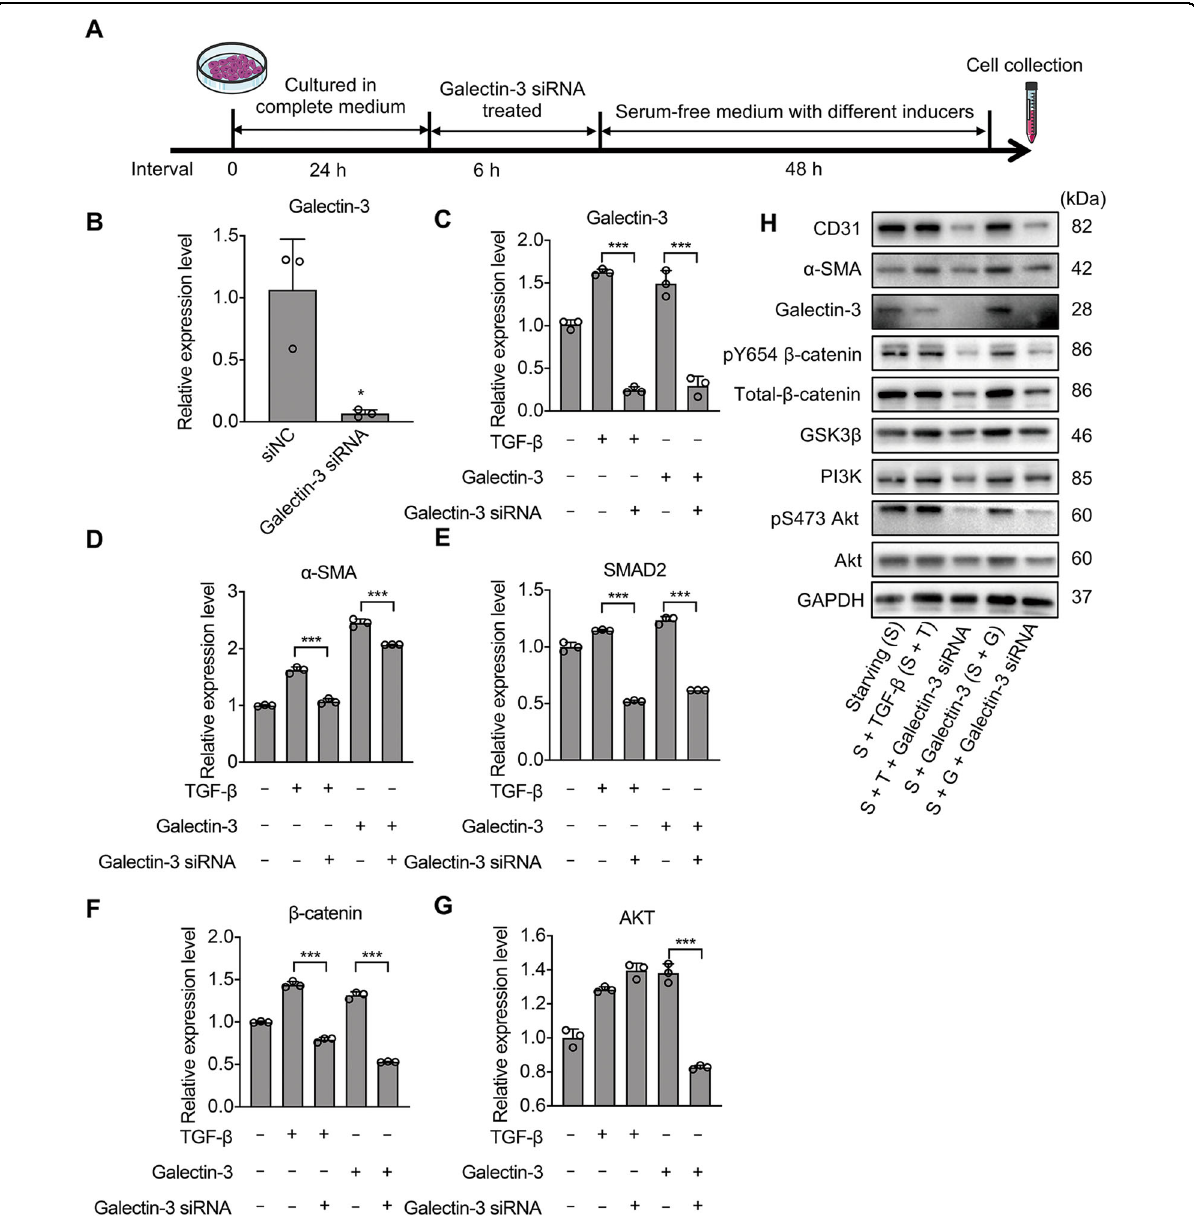
Fig. 7 Inhibition of galectin-3 expression ameliorates the EndMT process by downregulating the AKT/ β -catenin pathway in HPMECs. A Schematic showing the knockdown of galectin-3 expression with siRNA, and its impact on the transition of HPMECs. HPMECs were fi rst cultured in complete medium for 24 h, and then transfected with siRNA targeting galectin-3 for 6 h. After treatment with the siRNA, the complete medium was replaced with starvation medium (DMEM containing 1% FBS), followed by further cultivation for 48 h. B The knockdown ef fi ciency of galectin-3 siRNA according to RT-PCR. siNC: negative control. C – G HPMECs were stimulated with TGF- β (10 ng/ml, S + T) or galectin-3 (1 μ g/ml, S + G) and interfered with galectin-3 siRNA (S + T + galectin-3 siRNA and S + G + galectin-3 siRNA, respectively) for 48 h. Analysis of the expression level analysis of the target genes galectin-3, β -catenin, and SMAD2, as well as the fi broblast-related genes α -SMA and S100A in different experimental groups using RT- PCR. Error bars represent standard deviations, n = 3. H HPMECs lysate was analyzed for CD31, α -SMA, and AKT/ β -catenin signaling pathway regulators, total AKT and pS473 AKT, total- β -catenin and pY654 β -catenin, PI3K and GSK3 β by Western blotting. * p < 0.05, ** p < 0.01, *** p <